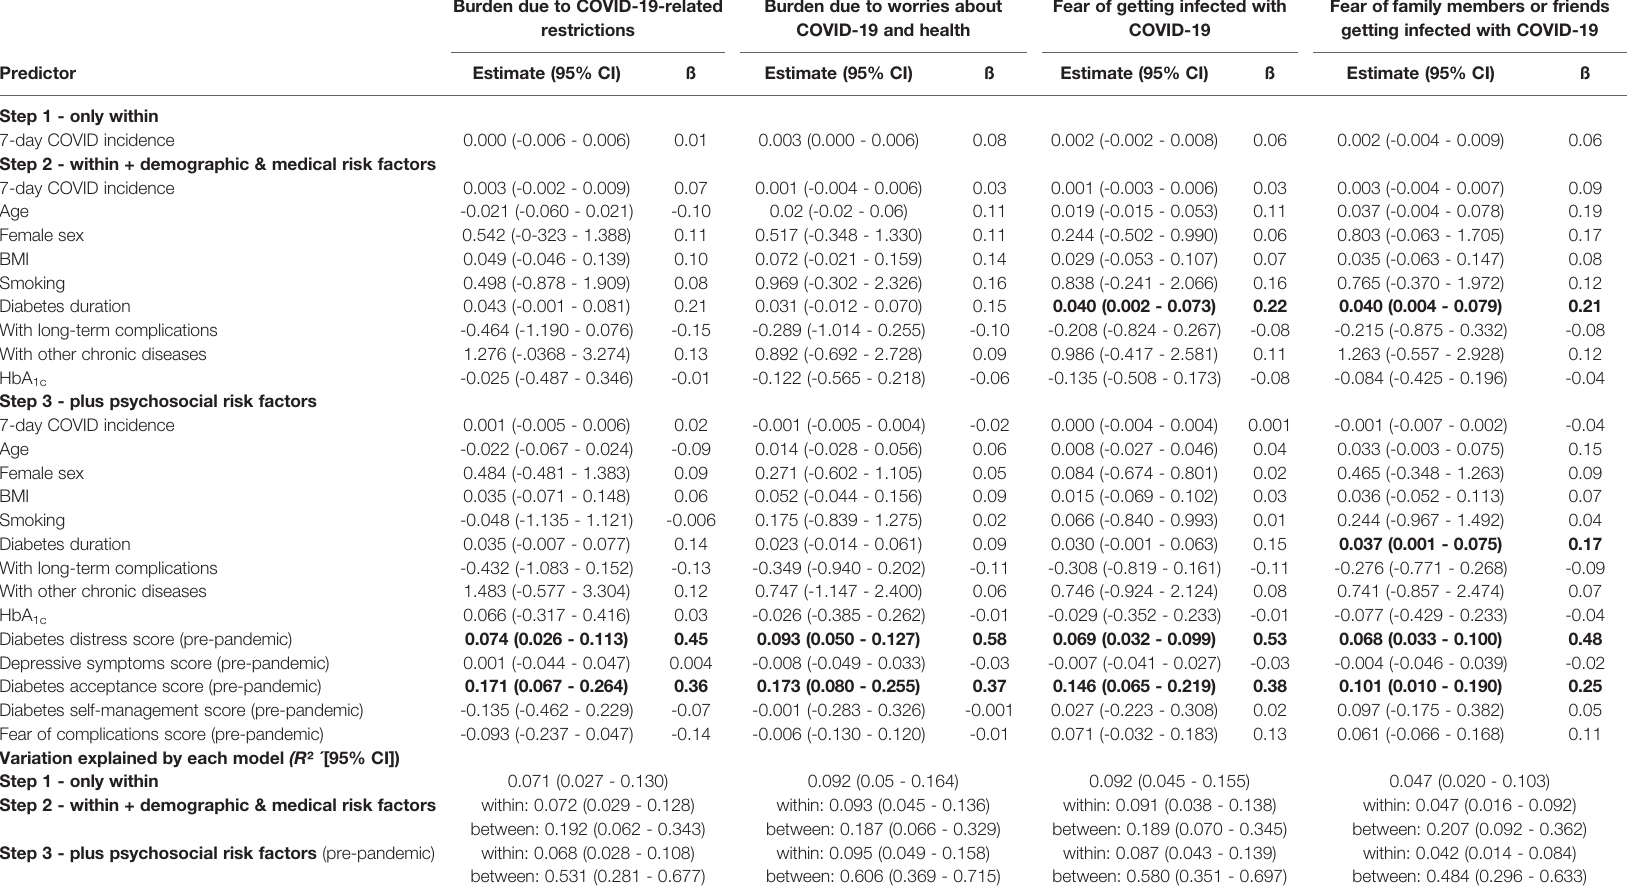
TABLE 2 | Multilevel analyses of variables to explain COVID-19-related burdens and fears.